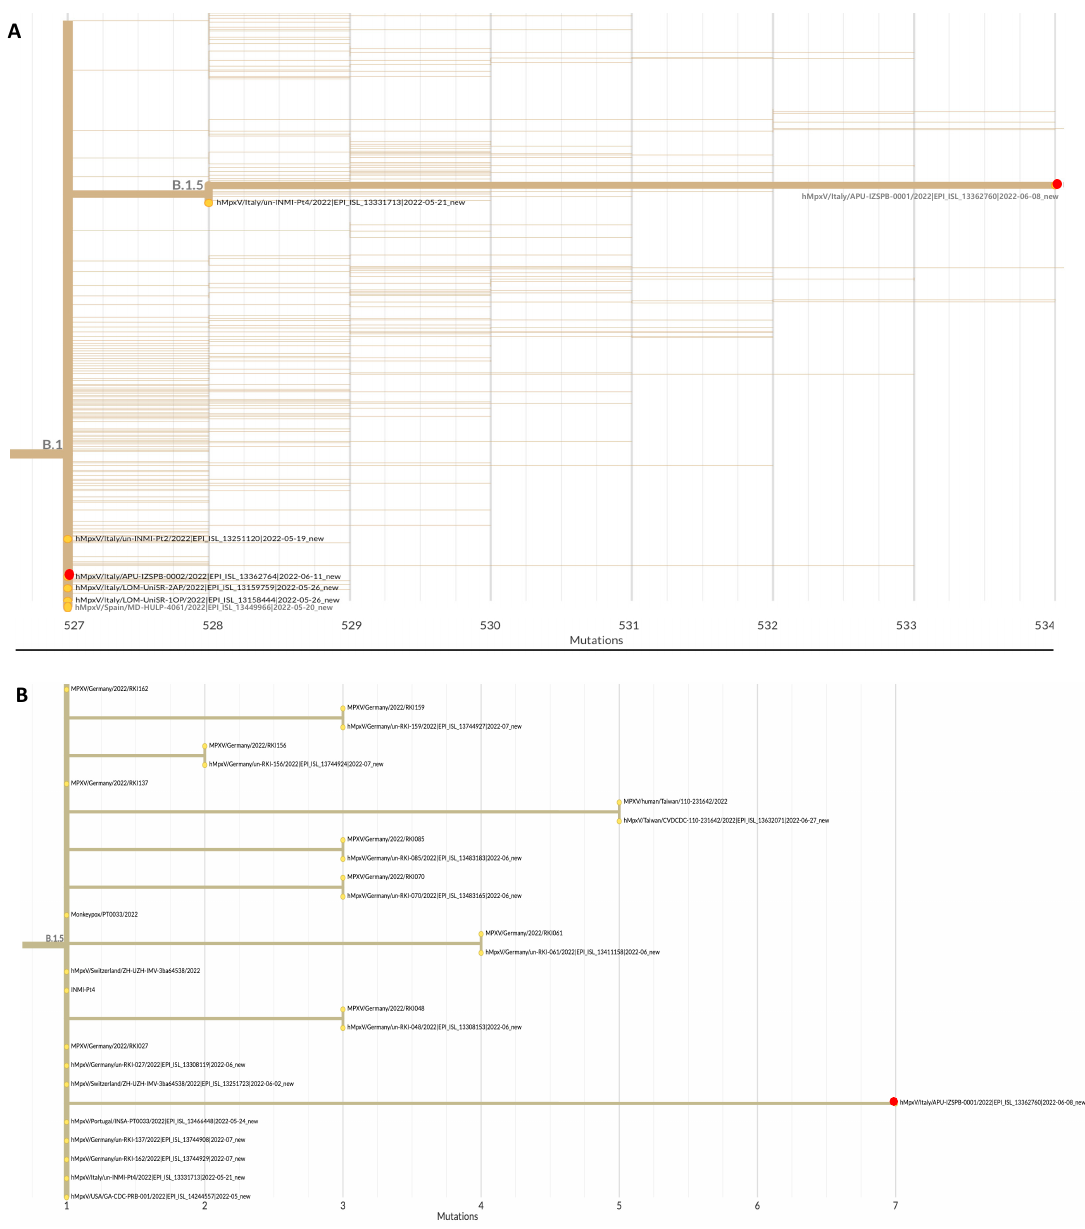
Figure 1. ( A ) Phylogenetic tree of the DNA sequences of samples from patients 1 and 2 in the Apulia region of Italy (red dots), and the sequences of representative Monkeypox genomes downloaded from the GISAID website (https://gisaid.org/, accessed on 17 August 2022); ( B ) phylogenetic tree of the DNA sequences of samples from patient 1 (red dot) and other sequences of representative Monkeypox genomes belonging to the same lineage of B.1.5. Accession numbers, the country of origin, and years are indicated. Phylogenetic analysis was performed using the Nextstrain web app (https://nextstrain.org/, accessed on 17 August